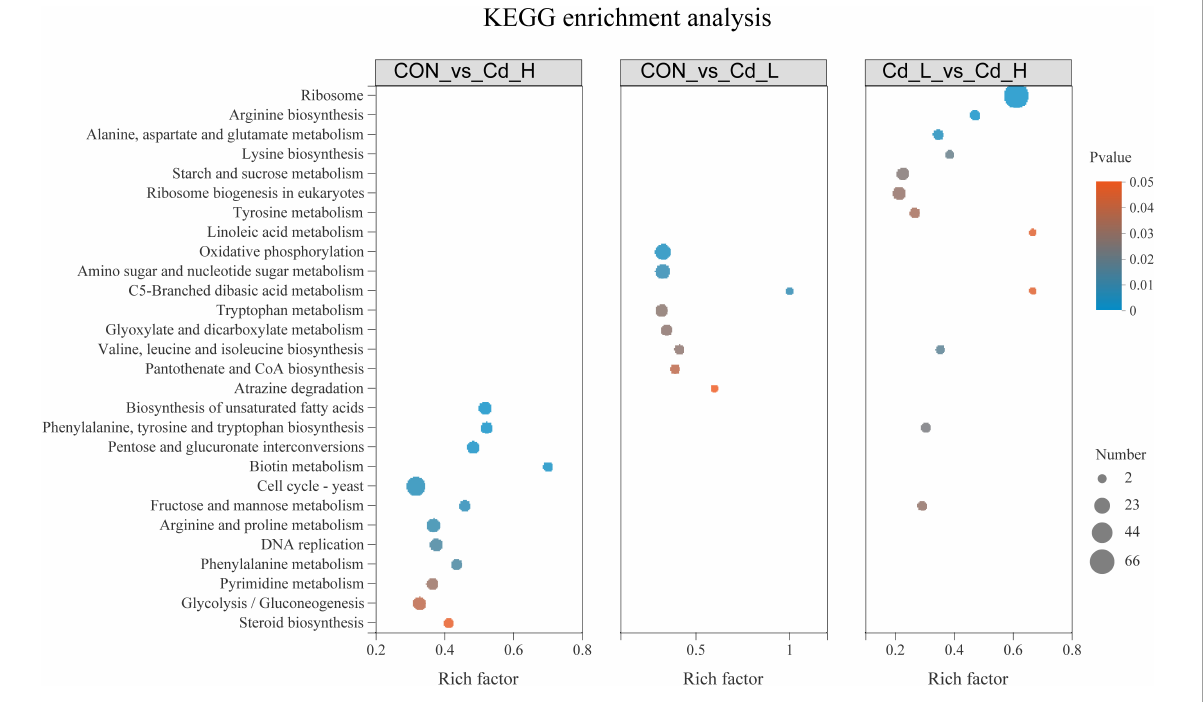
FIGURE4 Kyoto encyclopedia of genes and genomes (KEGG) pathway enrichment analysis between different Cd stress groups in the transcriptome. Cd, cadmium; Cd_L, low-dose Cd treatment group; Cd_H, high-dose Cd treatment group; CON, no Cd treatment group; KEGG, Kyoto Encyclopedia of Genes and